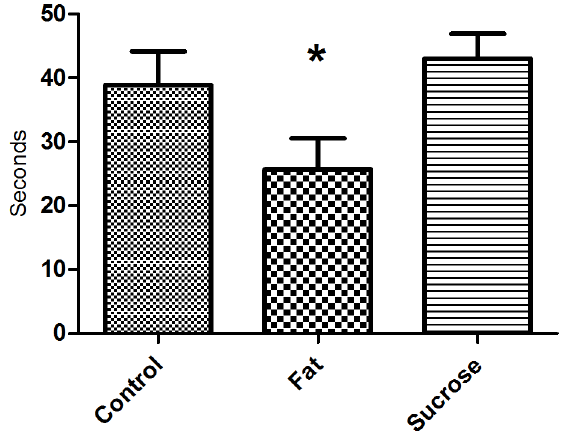
Figure 5. The Morris water maze test, preference for the previous platform area. Mice on high-fat diet spent significant less time in the area of the previous situated platform during the first 30 seconds of the retention trial compared to mice on high-sucrose diet. Memory of mice on control diet was similar to mice on high- sucrose diet. This indicate, that consuming a high-fat diet leads to decreased memory. Mean with SE.